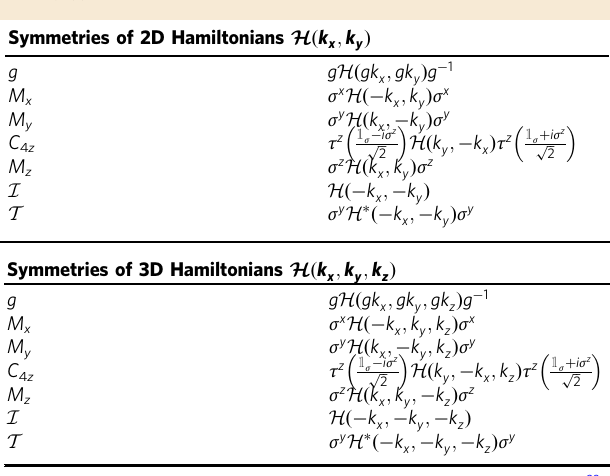
Table 1 The symmetry representation of the 2D and 3D s – d - hybridized models in the main text (Eqs. (1), (3), (4), (5), and